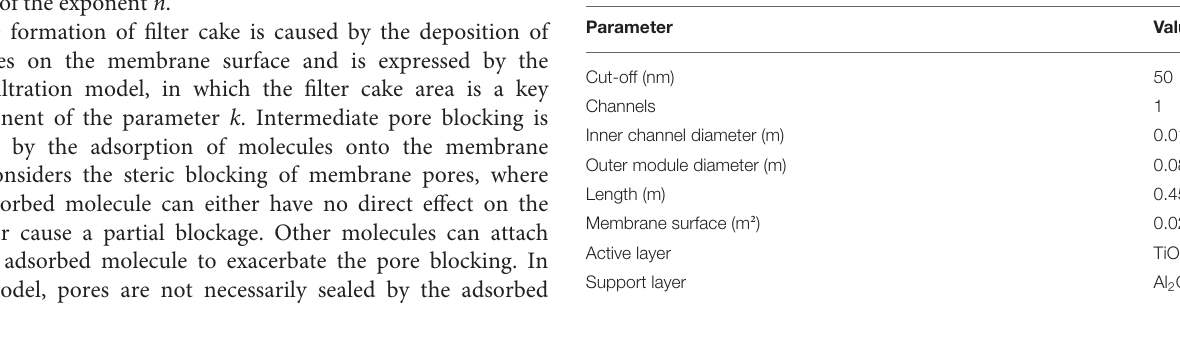
TABLE 2 | Parameters of the tubular ceramic membrane from Atech Innovations.